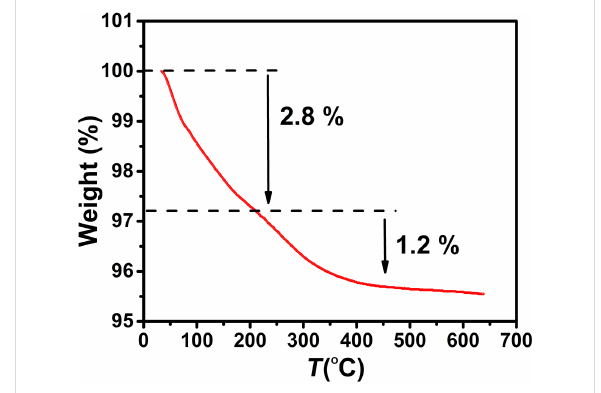
Figure 7: TGA curve of the CoFe 2 O 4 sample.